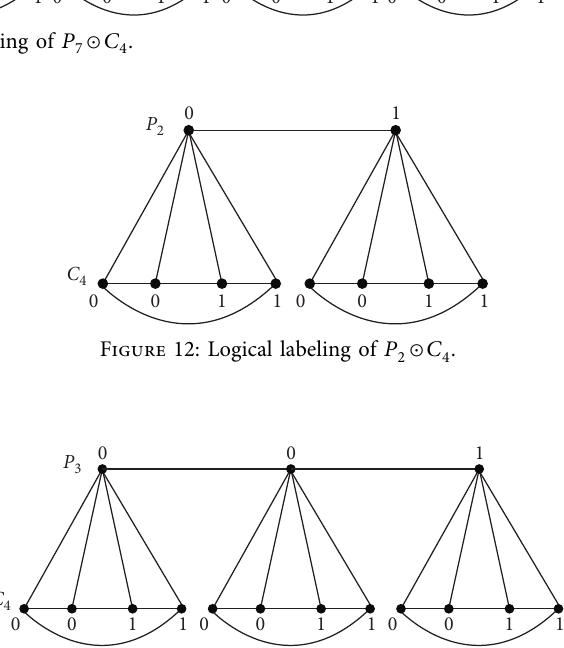
Figure 10: Logical labeling of P